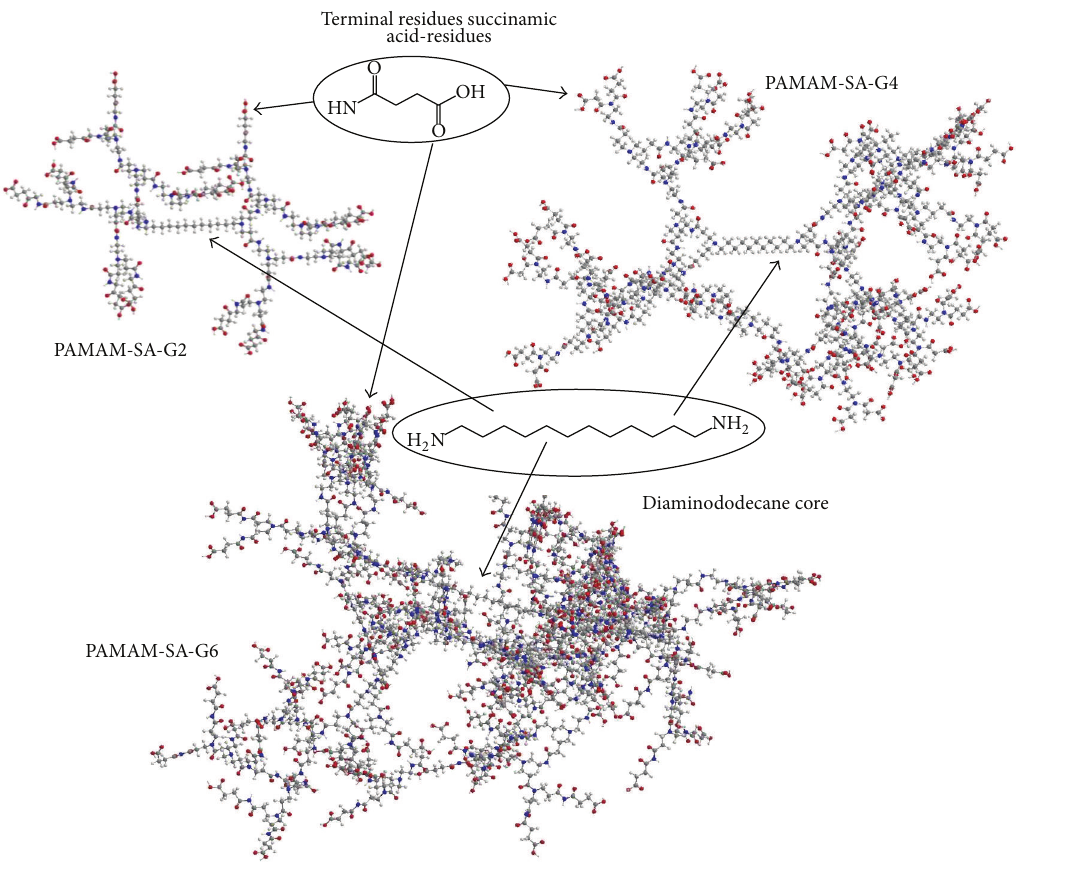
Scheme 1: Schematic view of the three types of dendrimer molecules used in this study: PAMAM-SA-G2, PAMAM-SA-G4, and PAMAM-